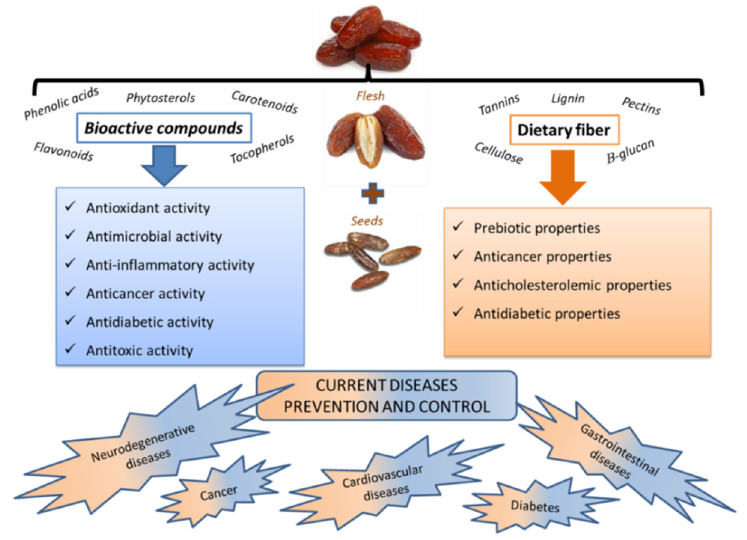
Figure 3. Health benefits of date fruit and the main compounds implied.